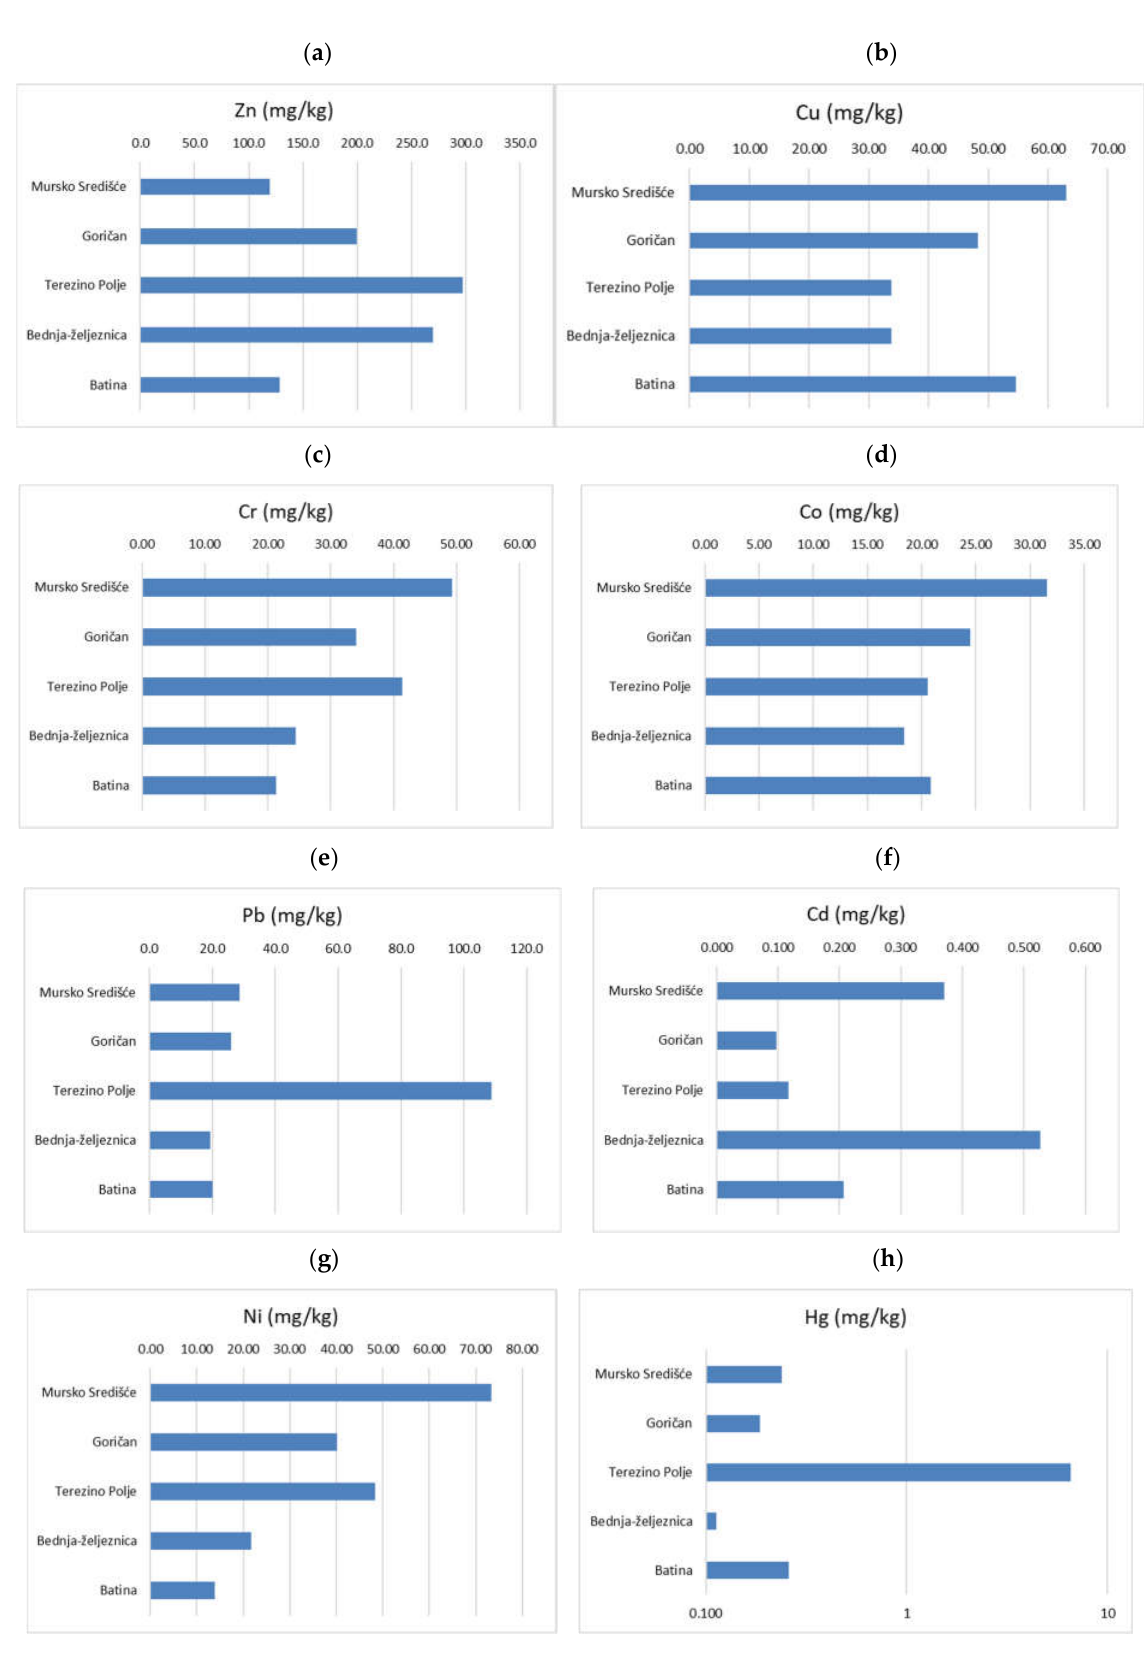
Figure 5. The average concentrations of Zn ( a ), Cu ( b ), Cr ( c ), Co ( d ), Pb ( e ), Cd ( f ), Ni ( g ), and Hg ( h ) in suspended sediment.